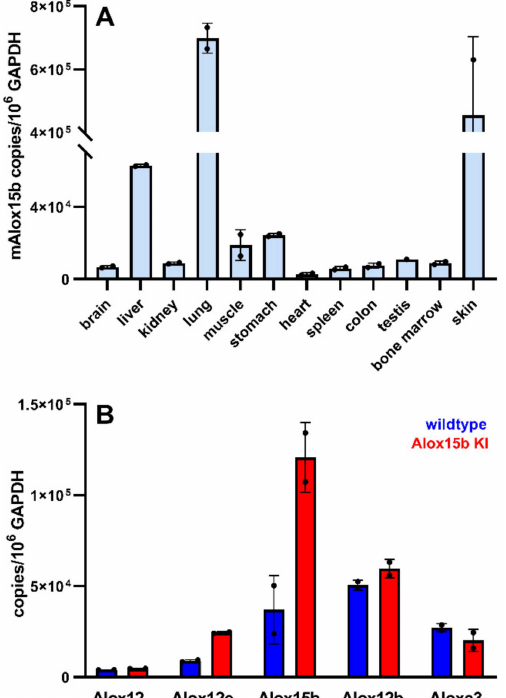
Figure 3. Expression of Alox isoforms in different mouse tissues. ( A ) Expression of Alox15b in different mouse tissues. Total RNA was extracted from different mouse tissues and Alox15b mRNA was quantified with qRT-PCR as described in Section 2. Two independent measurements ( n = 2) were carried out for each RNA extract. ( B ) Expression of Alox isoforms in PMA-treated mouse skin. Total RNA was extracted from PMA-treated tail epidermis of Alox15b -KI mice (red columns) and outbred wildtype controls (blue columns). Expression of the mRNA of different Alox isoforms was quantified by qRT-PCR. Two independent measurements ( n = 2) were carried out for each RNA extract. We also attempted to quantify expression of Alox15 and Alox5 but did not get specific PCR signals. Thus, these two Alox isoforms are not expressed on PMA-treated